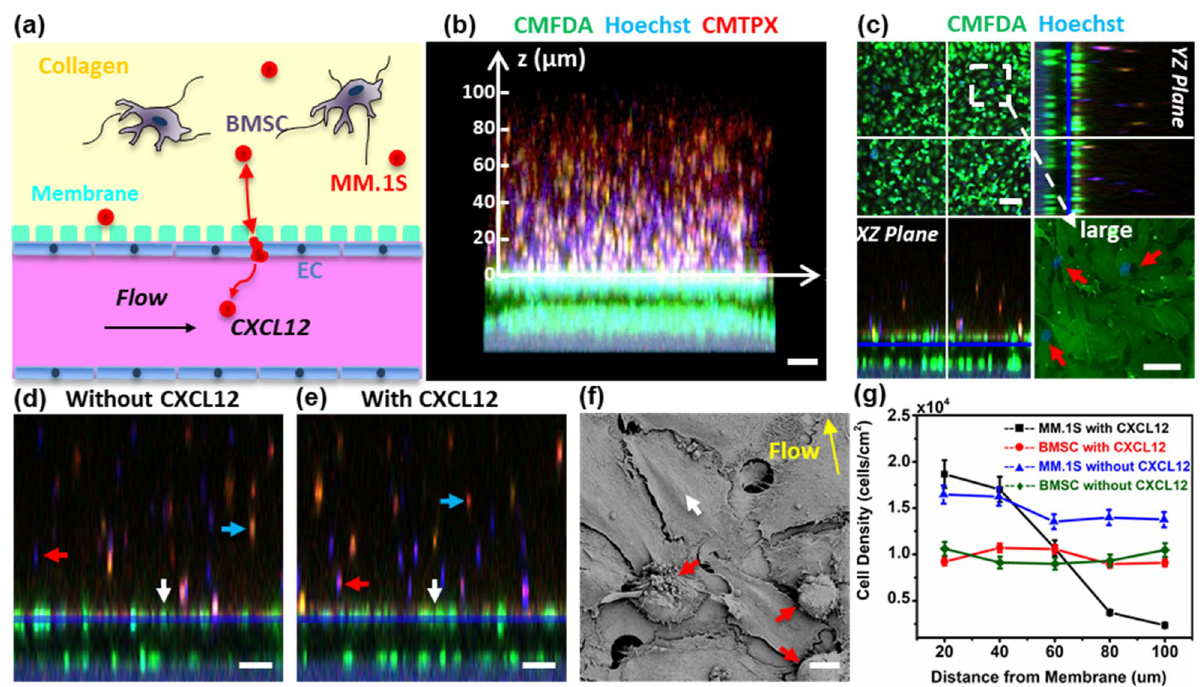
Figure 6. CXCL12-meditated egression of MM.1S cancer cells from the BM stroma chamber. ( a ) Schematic representation of cells inside the device. ( b ) Confocal cross-sectional view of the device after adding CXCL12- containing medium in the sinusoid chamber for 4 h; ECs (CMFDA green), BMSCs (CMTPX red), MM.1S cells (Hoechst blue). Scale bar = 200 µm. ( c ) Z-stack projection of confocal fluorescence images of MM.1S migration after adding CXCL12. Scale bar of z-projection = 100 µm. Scale bar in the larger image = 20 µm. ( d ) and ( e ) Cross-sectional confocal fluorescence views with and without CXCL12, respectively. Scale bar = 100 µm. ( f ) SEM image of the endothelium infiltrated with MM.1S cells. Scale bar = 10 µm. ( g ) Number density of Hoechst- stained MM.1S cells was manually counted and averaged at six different locations (n = 6) in the z-direction of ( b ). In ( c )–( f ), red arrows indicate MM.1S cells, white arrows indicate ECs, blue arrows indicate BMSCs, and yellow arrow indicates flow cultured using the 1:1 mixture of the DMEM and RPMI complete cell culture media. CXCL12 was added in the common culture medium fed into the sinusoid chamber after ECs, BMSCs, and MM.1S were cultured in the device for 26 h. Fluorescence images and videos were taken in situ using the confocal and fluorescence micros- copy for the following 4 h (Supplementary Information 5). To help maintain the CXCL12 gradient, the culture medium in the culture medium reservoir was replenished every 10 min during the 4-h period.